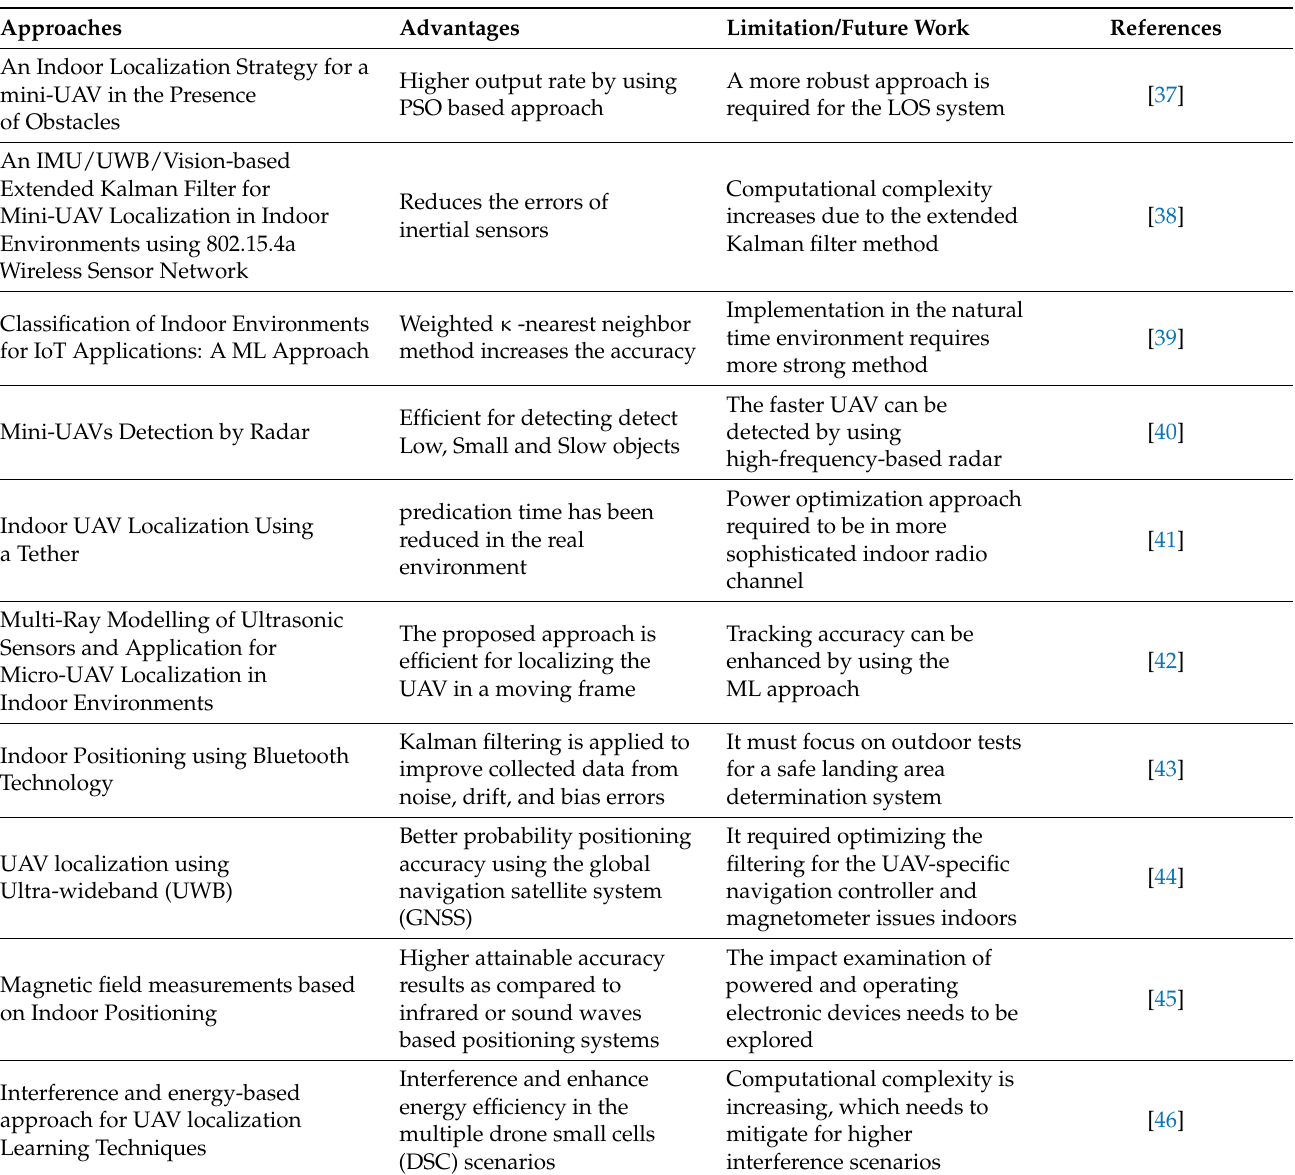
Table 1. Summary of existing studies on indoor